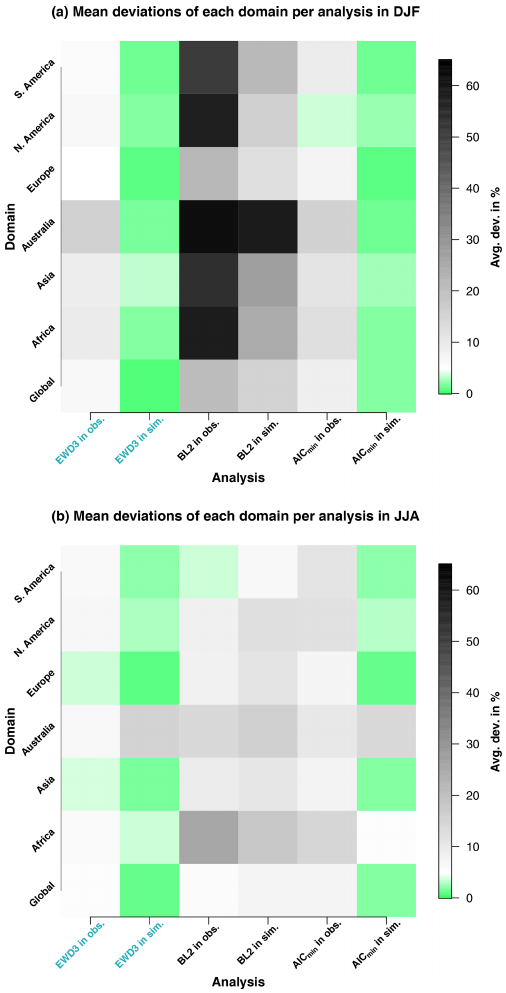
Figure 7. Mean deviations from N 0 , 1 per SPI category during DJF (a) and JJA (b) . Mean deviations are displayed for each inves- tigated domain and each analyzed PDF for observations and simu- lations.